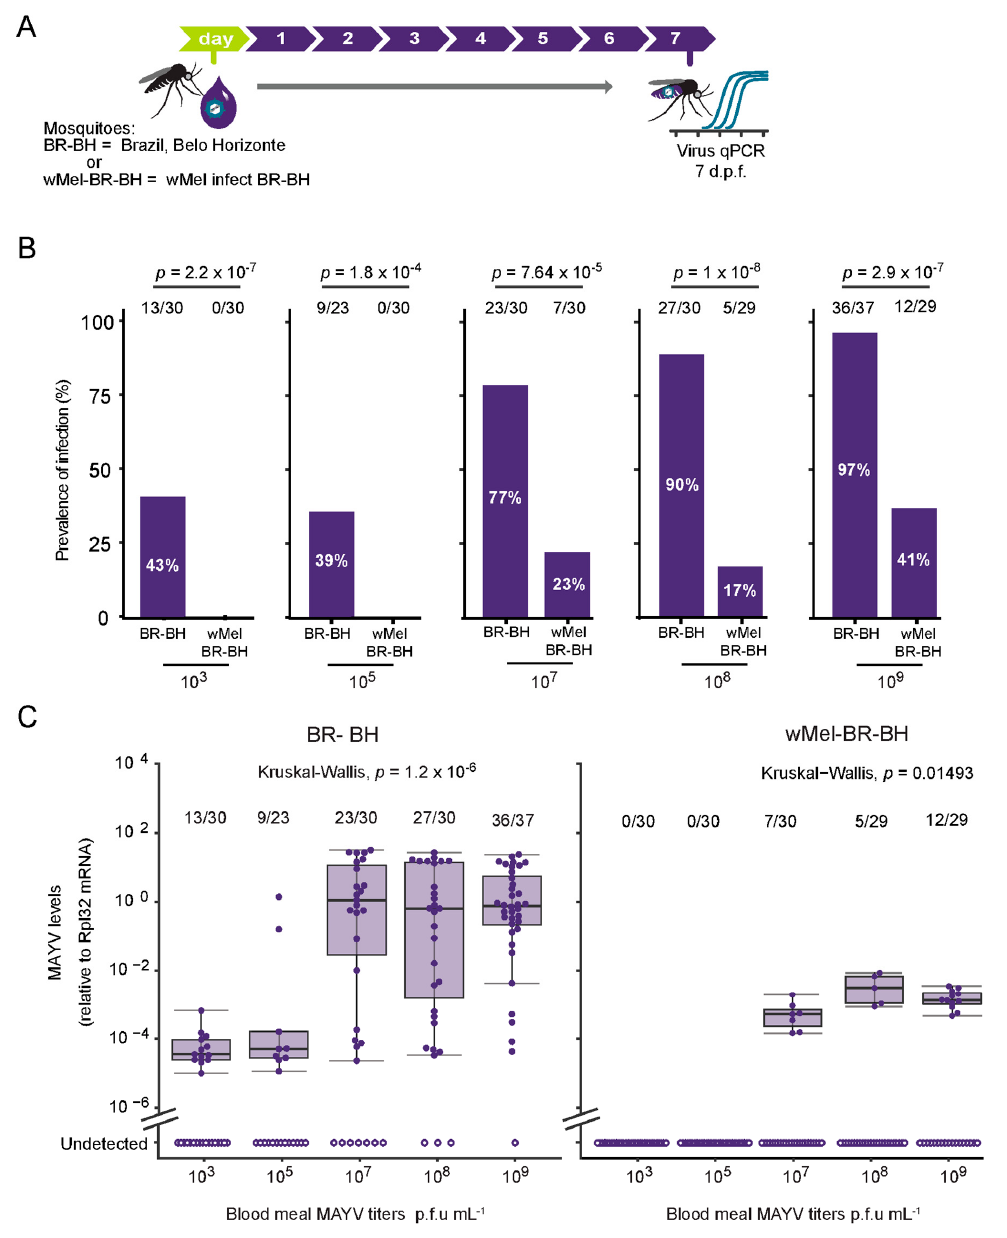
Figure 1. Characterization of MAYV oral infection in Aedes aegypti mosquitoes. ( A ) Scheme of the experimental design. BR-BH or w Mel-BR-BH 5-7 days old were fed on a blood meal containing 10 3 , 10 5 , 10 7 , 10 8 or 10 9 p.f.u. mL − 1 of MAYV. Mosquitoes were collected at 7 d.p.f and tested individually by qPCR to detect viral RNA levels. ( B ) Prevalence of infection. Total number of mosquitoes tested are indicated above each column. Statistical analyses were performed using the two-tailed Fisher’s exact test. ( C ) MAYV RNA levels at 7 d.p.f. Each dot represents an individual whole mosquito. Bars in boxplot represent median viral load after log 10 transformation. Upper and lower limit of the boxplot represent 75th and 25th percentile, respectively. Whiskers represent error bar using +/ − 1.5 × QR. Dots located outside the whiskers represent outliers. Statistical analyses were performed using the Kruskal-Wallis test, comparing the MAYV titers of the infected mosquitoes.